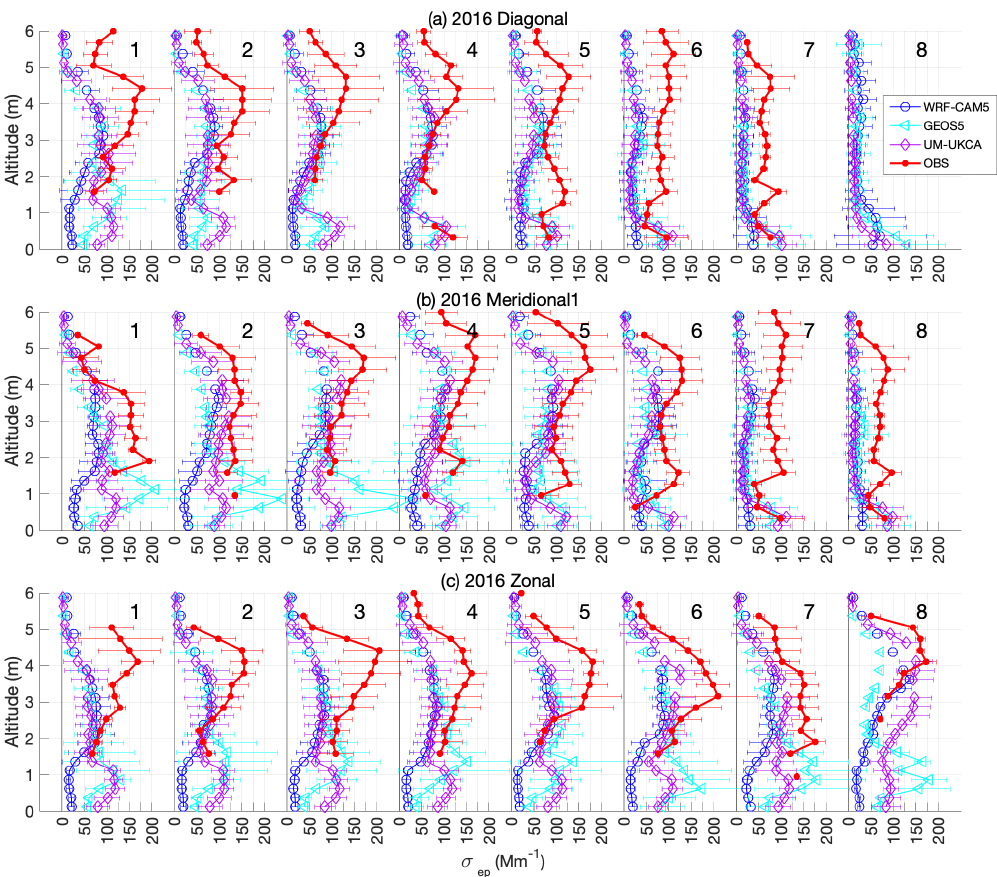
Figure 8. As in Fig. 6 but for the HSRL-2 retrievals of σ ep from the ER2 aircraft in 2016. Here, all values are at ambient RH.